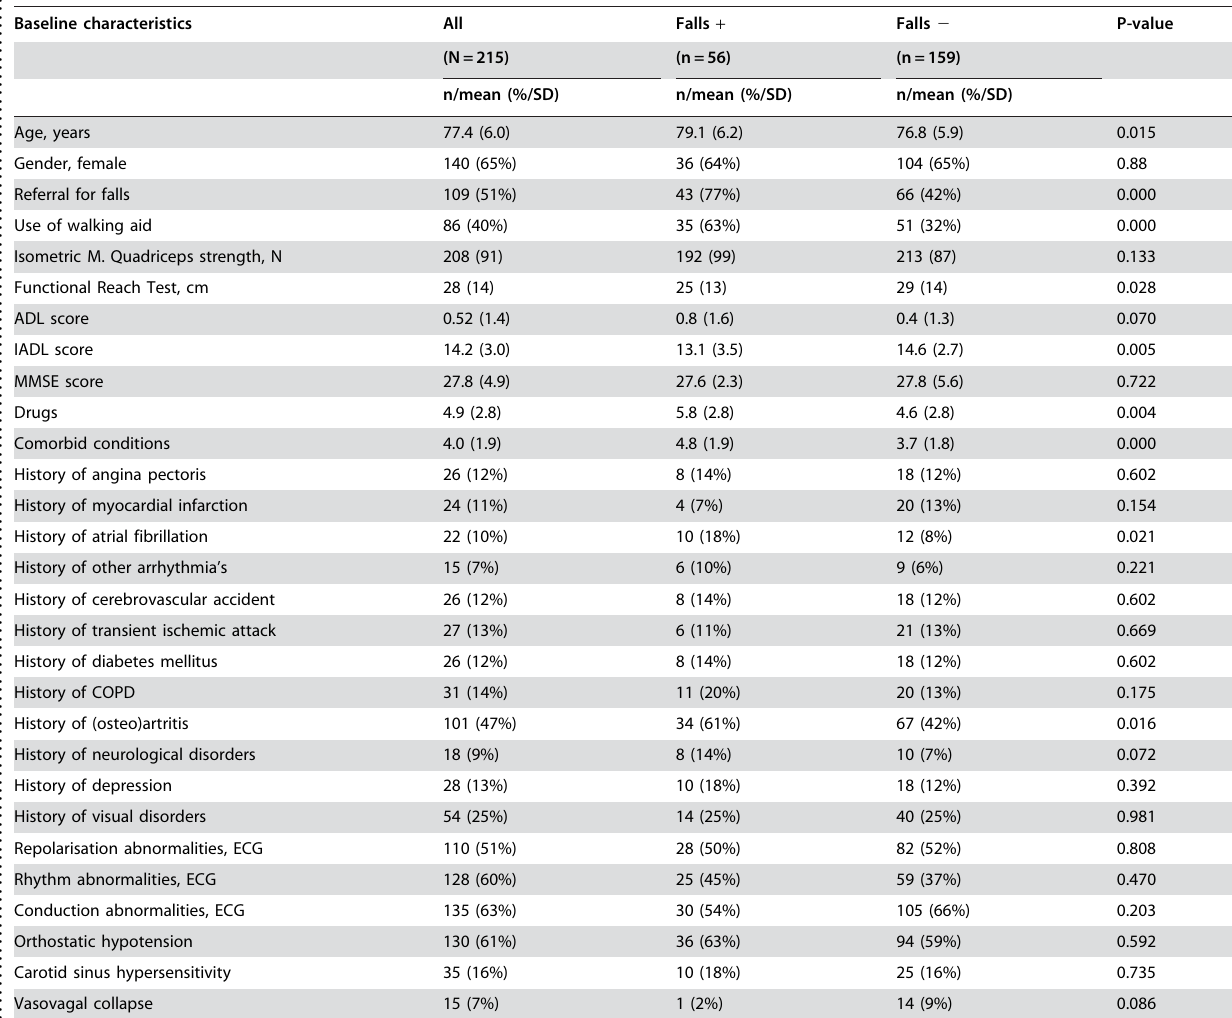
Table 1. Baseline Characteristics of Study Population. .. ... .... ... ...